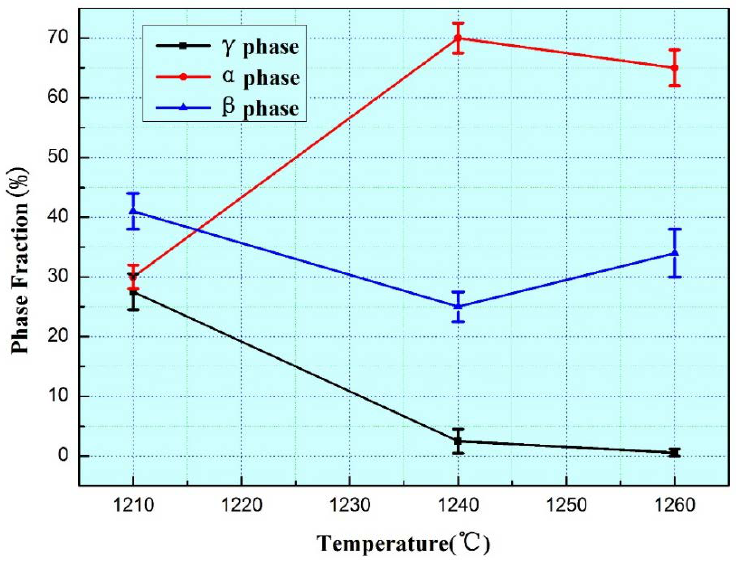
Figure 6. Volume fraction of γ - phase, α -phase, and β -phase at different temperatures.